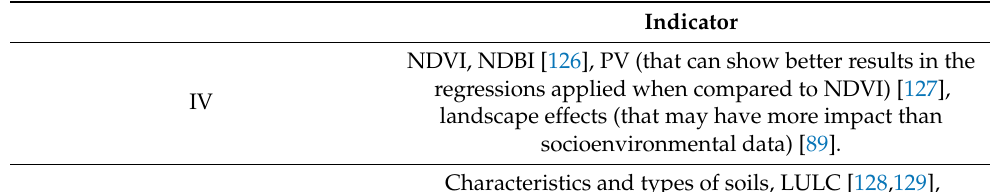
Table 14. Indicators for understanding UHI and